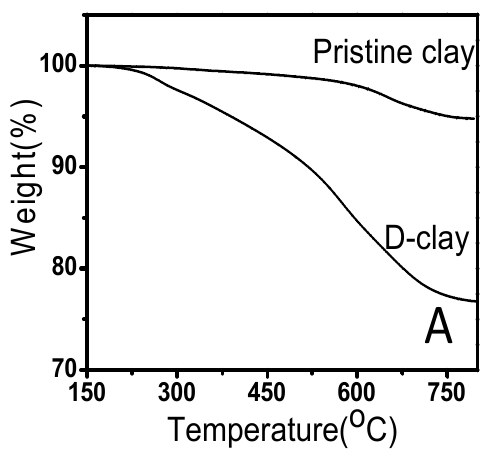
Figure 2. TGA curves of pristine clay (MMT) and D-clay (1.5 mg/mL DOPA concentration) in air.